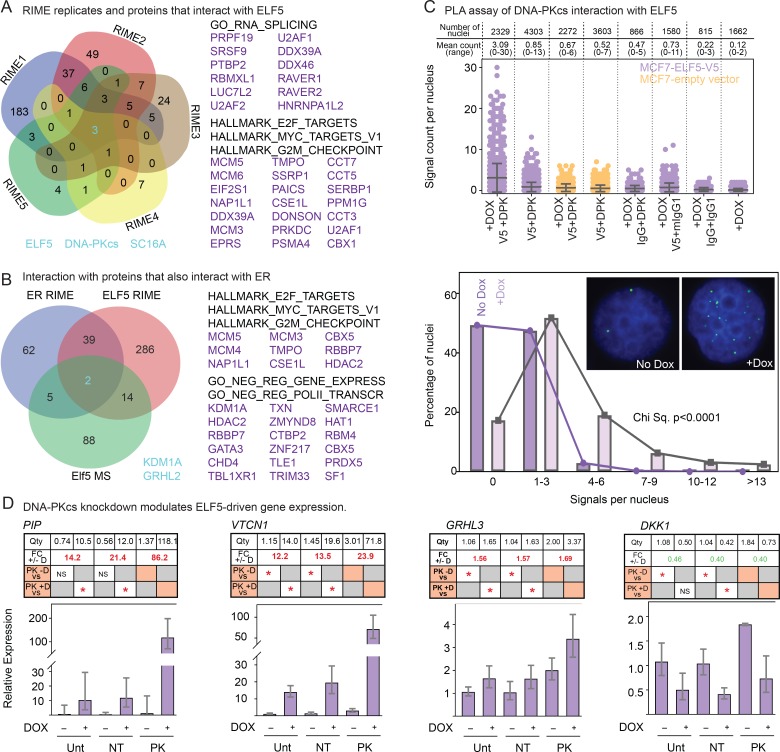
Identification of ELF5 binding partners.Panel A, Overlap of proteins identified in the ELF5 RIME replicates 1–5 following removal of non-specific interactors. Three proteins (ELF5, DNA-PKcs and SC16A) were identified in all replicates and no IgG controls. Gene lists show functional analysis using GSEA of interactors present in 2 of 5 replicates and not present in the IgG controls, full gene list provided in S1 Table. Panel B, overlap between ELF5-interacting proteins identified in at least one MCF7 ELF5 RIME replicate and those identified in mouse trophoblast cells [49], and ER RIME in MCF7 cells [34], revealing GRHL2 and KDM1A as potential common interactors. Gene lists show functional analysis using GSEA of interactors also present in ER RIME and not present in the IgG controls, full gene list provided in S2 Table. Panel C, top, proximity ligation assay (PLA) data showing increased signal count per nuclei between ELF5 and DNA-PKcs (DPK). Lower panel bar chart shows statistical analysis of the shift in the distribution of PLA signals per nucleus. Inset shows an example of increased PLA signal with induction of ELF5. Panel D, Effect of DNA-PKcs knockdown on ELF5-driven changes in expression of the indicated genes. Graphs show the mean calibrated normalised relative quantity values from three biological replicates with error bars showing 95% confidence interval. The associated table, vertically aligned with the corresponding samples in the graph, provides the exact mean normalised quantity value (Qty, row 1). Row 2 of the table indicates the effects of ELF5 induction on the target gene expression; the fold changes (FC) for the vertically aligned doxycycline induced (+D) or not induced (-D) sample pairs are shown, with red typeface indicating a significant upregulation, green a significant down regulation (one-way ANOVA). Rows 3 and 4 of the table indicate the effect of DNA-PKcs (PK) knockdown on the target gene expression. Row 3 compares the siPK-D sample (indicated by the orange box) with each of the untransfected (Unt) -D and the non-targeting (siNT) -D control samples, with a red asterisk indicating a significant upregulation and NS = no significant difference, one-way ANOVA). Similarly, row 4 compares the siPK+D sample (indicated by the orange box) with each of the untransfected (Unt) +D and non-targeting (siNT) +D samples.